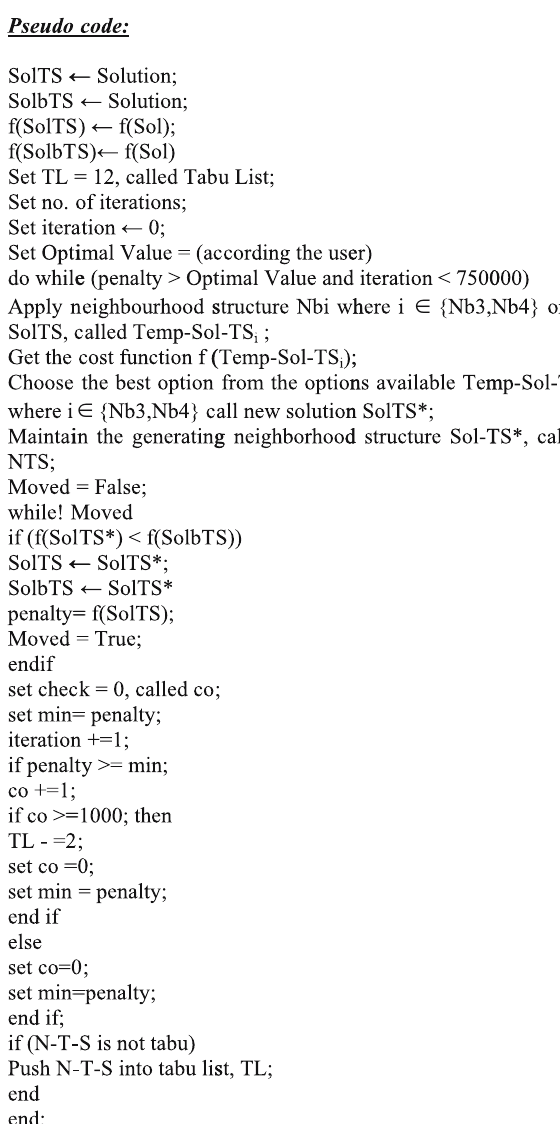
Figure 2: Pseudocode for the adaptive tabu search